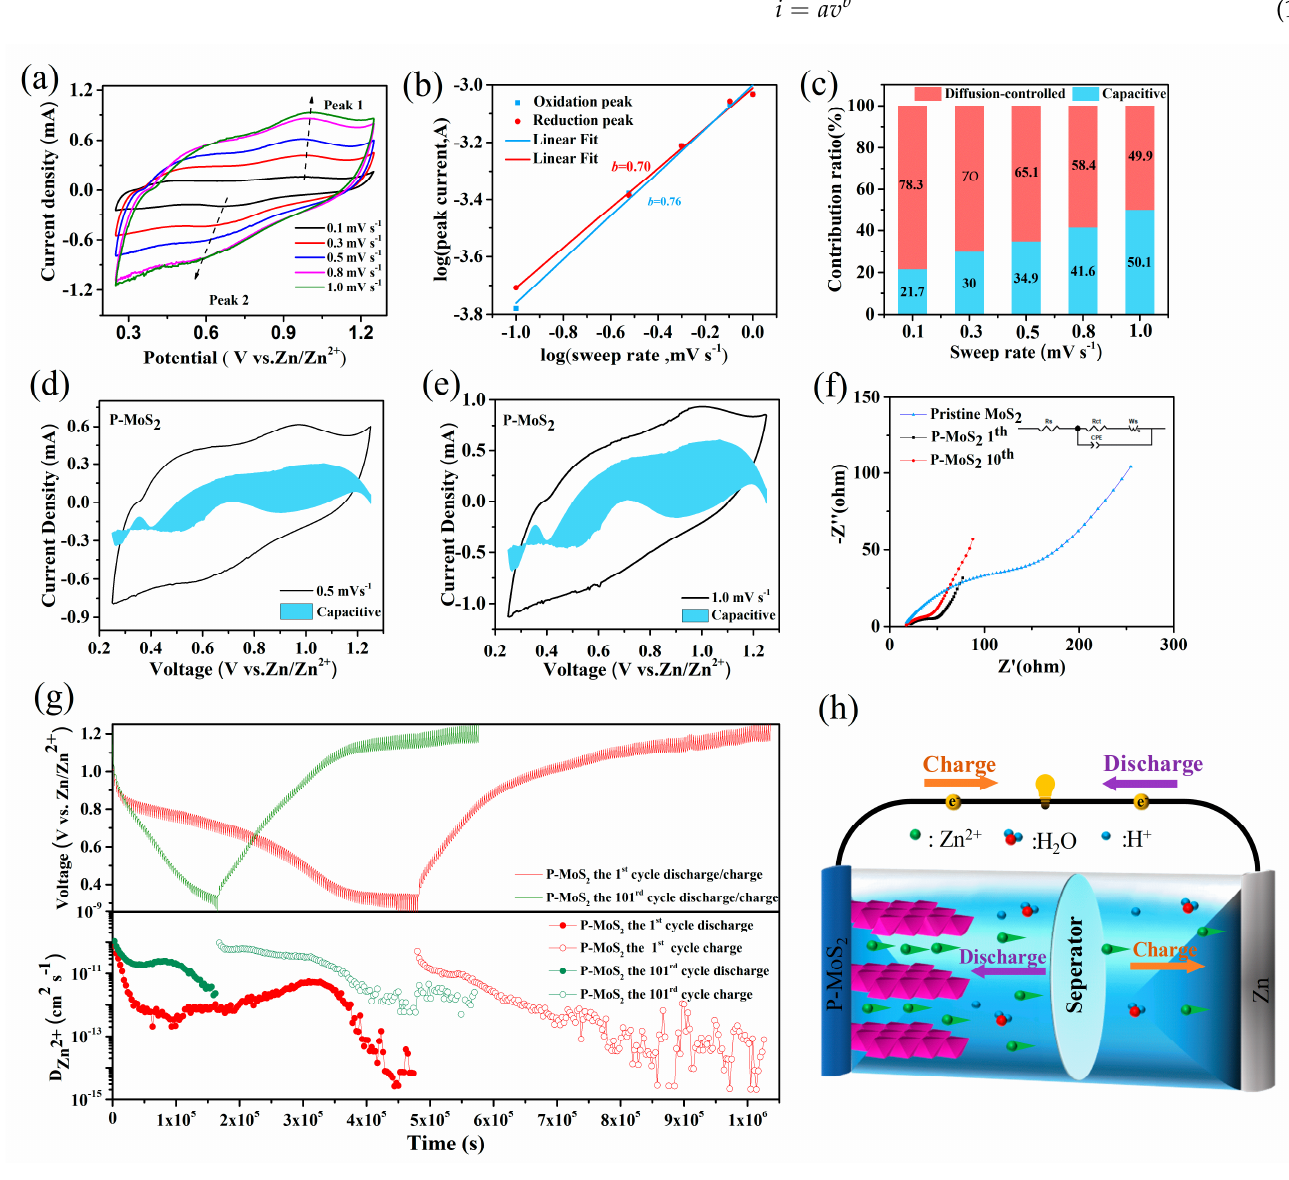
Figure 6. Electrochemical kinetics characterization for the P-MoS 2 electrode. ( a ) CV curves at various scan rates. ( b ) Log ( i ) versus log ( v ) plots of the redox peaks corresponding to the CV data. ( c ) Capacitive separation curves at 0.5 mV s − 1 ( d ) Capacitive separation curves at 0.5 mV s − 1 . ( e ) Capacitive separation curves at 1 mV s − 1 . ( f ) EIS spectra, insert image is the fitted equivalent circuit models. ( g ) Discharge/charge GITT profiles and corresponding D Zn . ( h ) Schematic diagram for Zn-storage mechanism of P-MoS 2 .